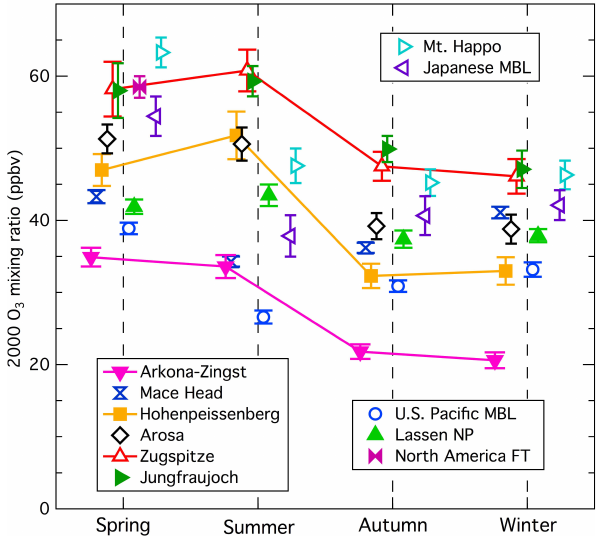
Fig. 6. Summary of year 2000 intercepts of the linear regressions to the eleven northern mid-latitude data sets in each season. The six European data sets are given to the left of the vertical dashed lines, while the three North American and two Japanese data sets are to the right. The sites are positioned in order of increasing elevation within their respective continents. For clarity line segments connect the seasonal intercepts for three of the